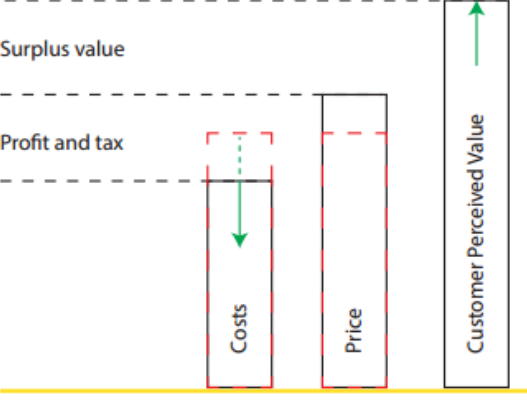
Figure 5. The costs, the price, and the Customer Perceived Value (CPV) of a product.